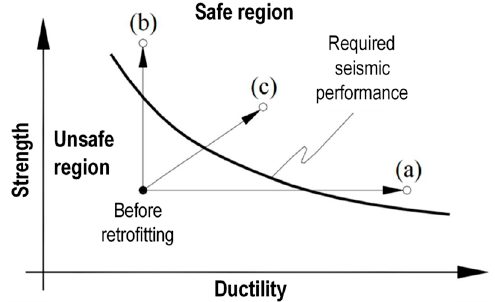
Figure 7. Comparison between retrofitting systems: An FRP reinforcement leads the structure to point ( b ), increasing strength but not ductility; a three dimensional reinforcement with steel ribbons leads the structure to point ( a ), increasing ductility but not strength; the combined technique leads the structure to point ( c ), increasing both strength and ductility.